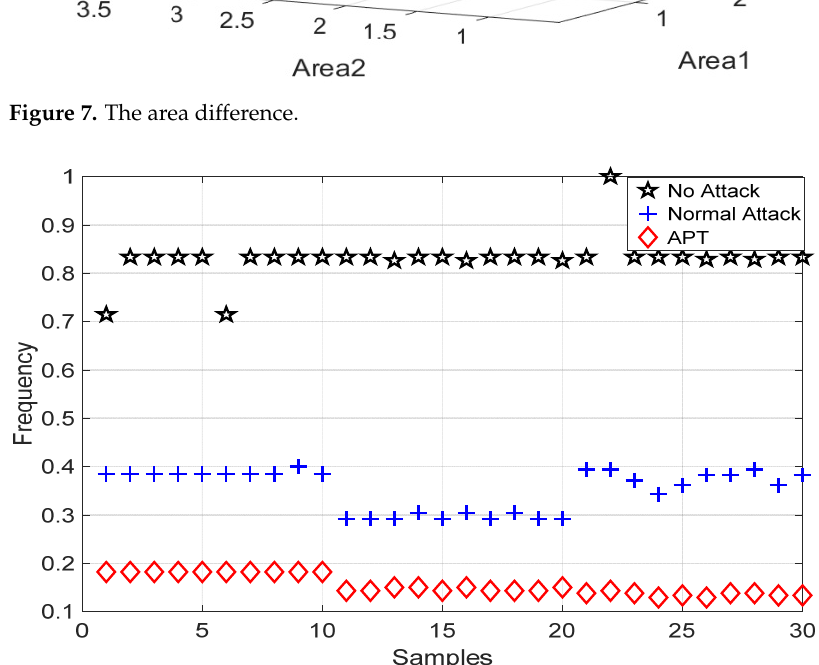
Figure 8. The rate difference.